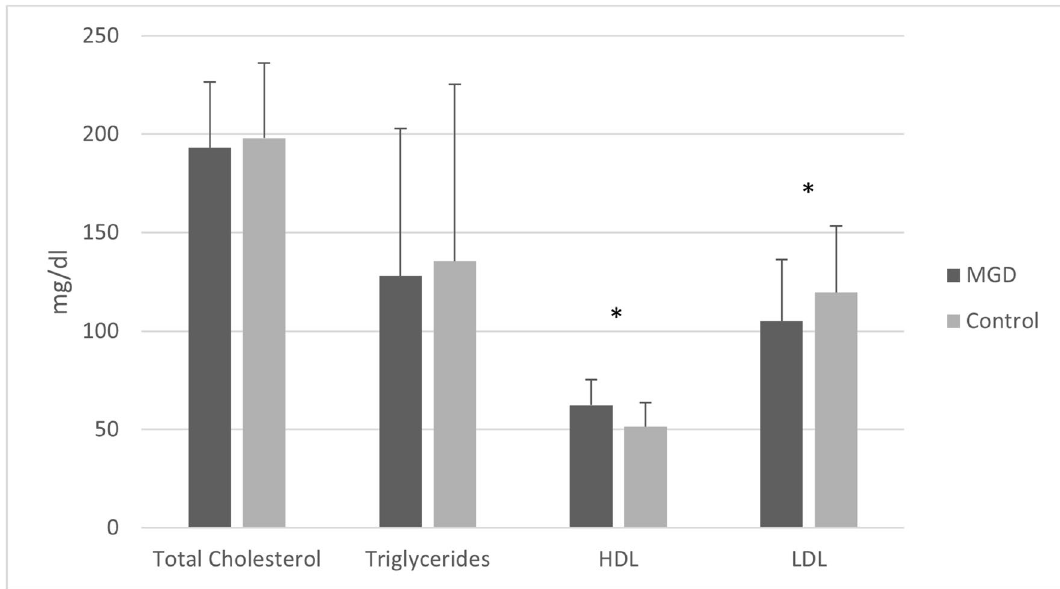
Figure 3. Mean value and standard deviation of lipid profile (TC, TG, HDL, LDL) of MGD and control patients. The HDL level of MGD patients was statistically significantly higher than that of the control group (P < 0.0001).